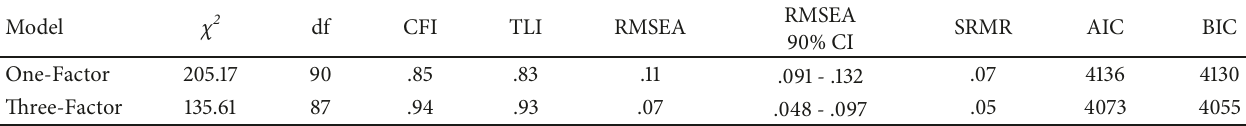
Table 5: Goodness of-fit indices of CFA